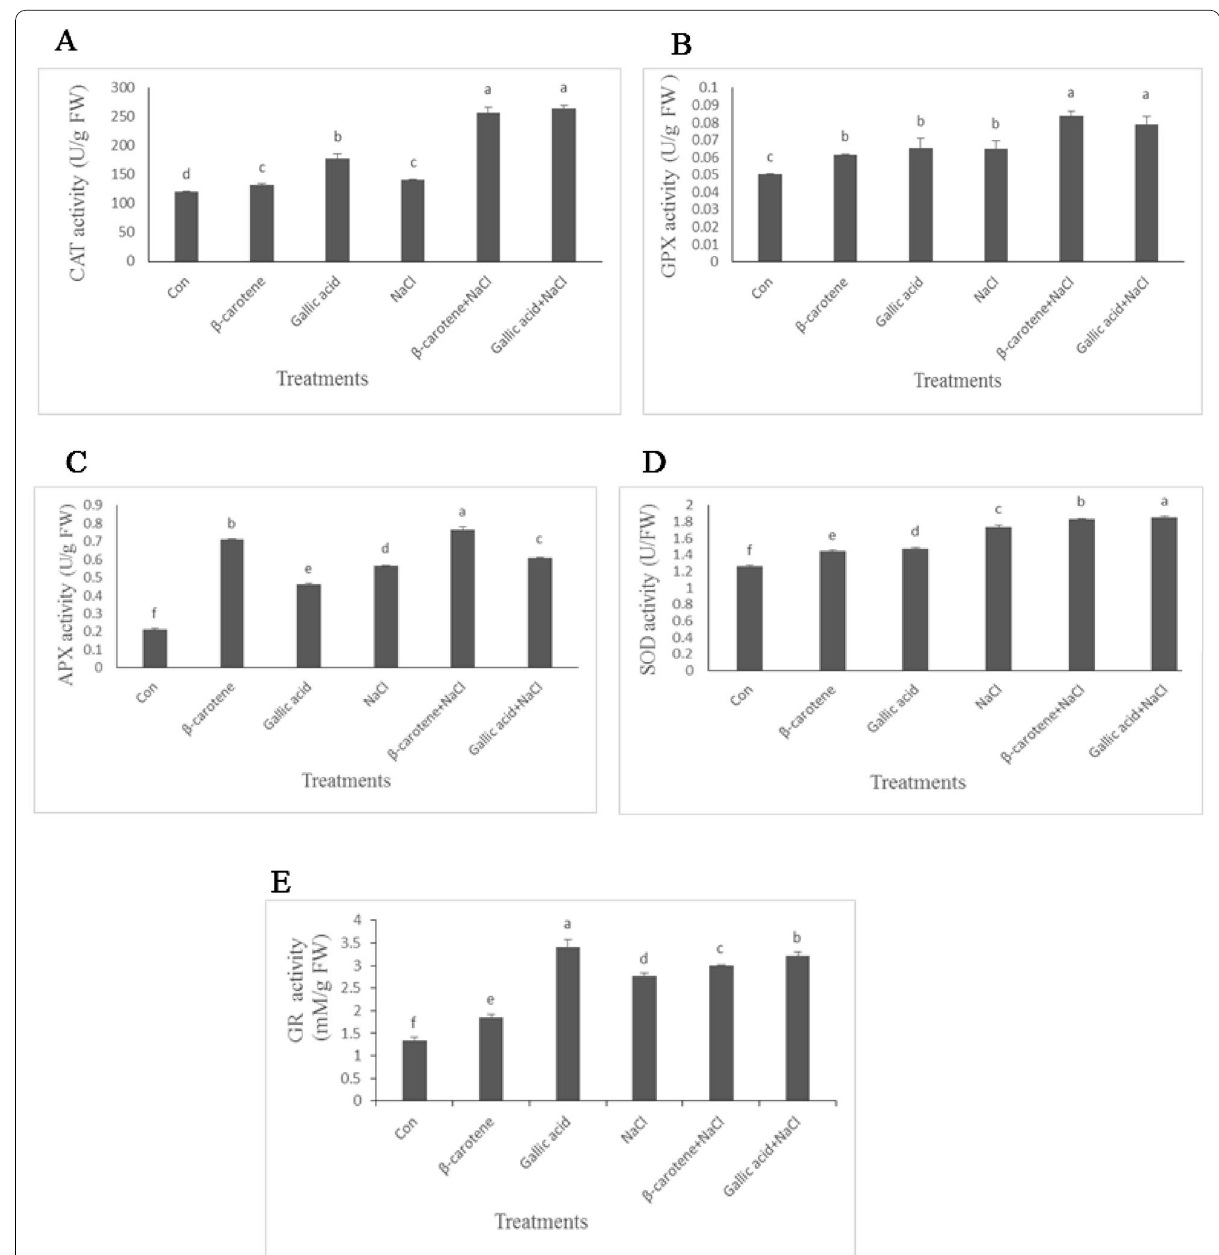
Fig. 6 Effect of β‑carotene and gallic acid, under saline and non‑saline conditions on the activity of CAT ( A ), GPX ( B ), APX ( C ), SOD ( D ), GR ( E ) in Lepidium sativum seedlings. Columns with the same letters are not statistically different at 5% probability using Duncan’s